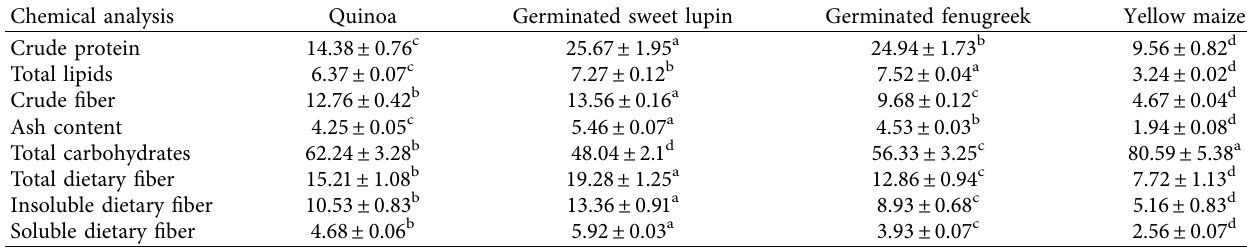
Table 2: Proximate compositions of raw materials (g/100g DW).